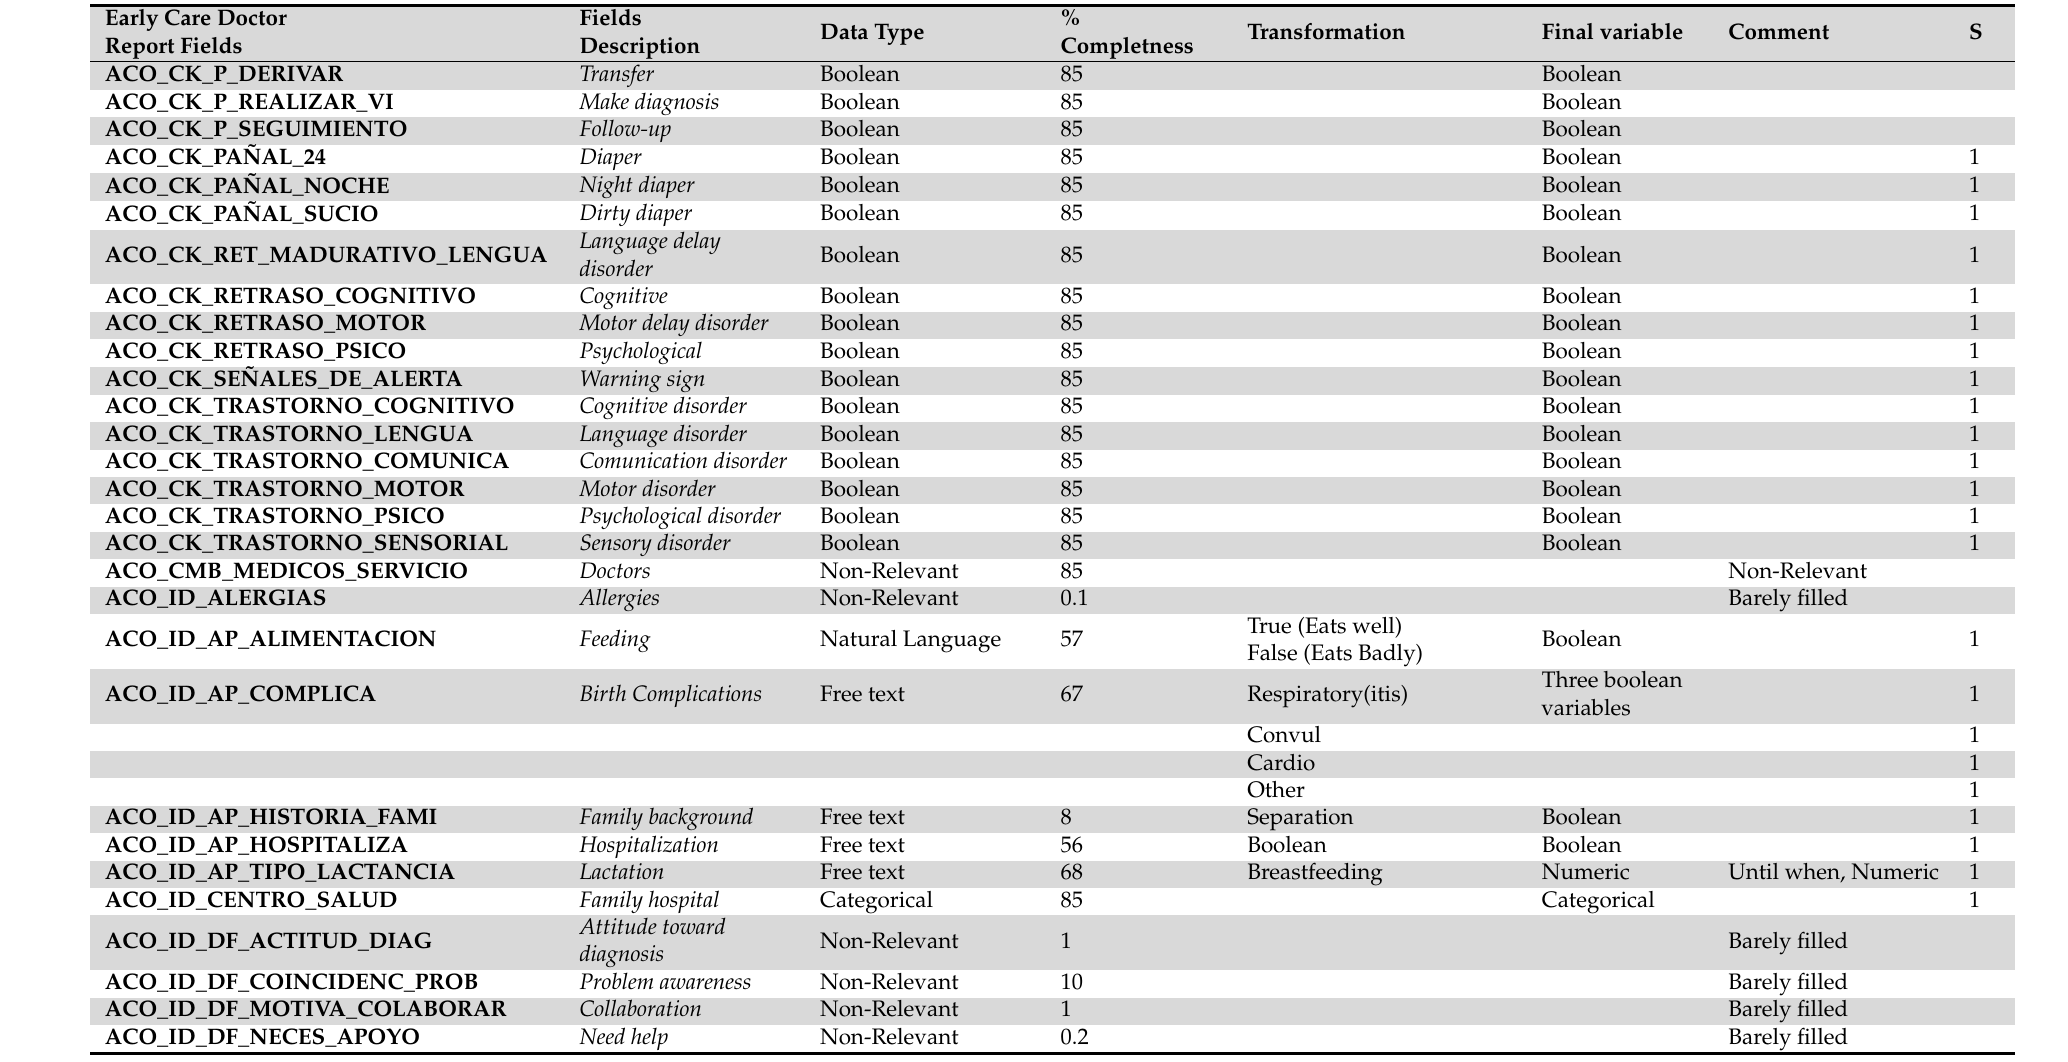
Table 1. Data extracted from the